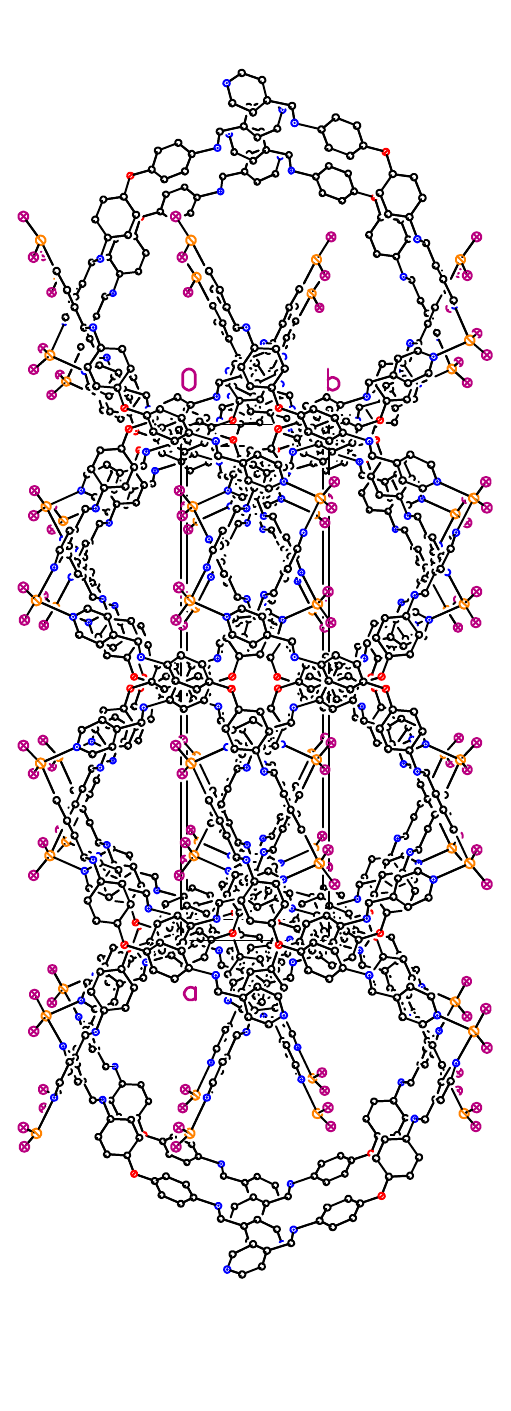
Figure 4. A parallel view on the lateral packing of double stranded helices in 1 and their interconnection leading to a coordination network. H atoms and solvent molecule are omitted for